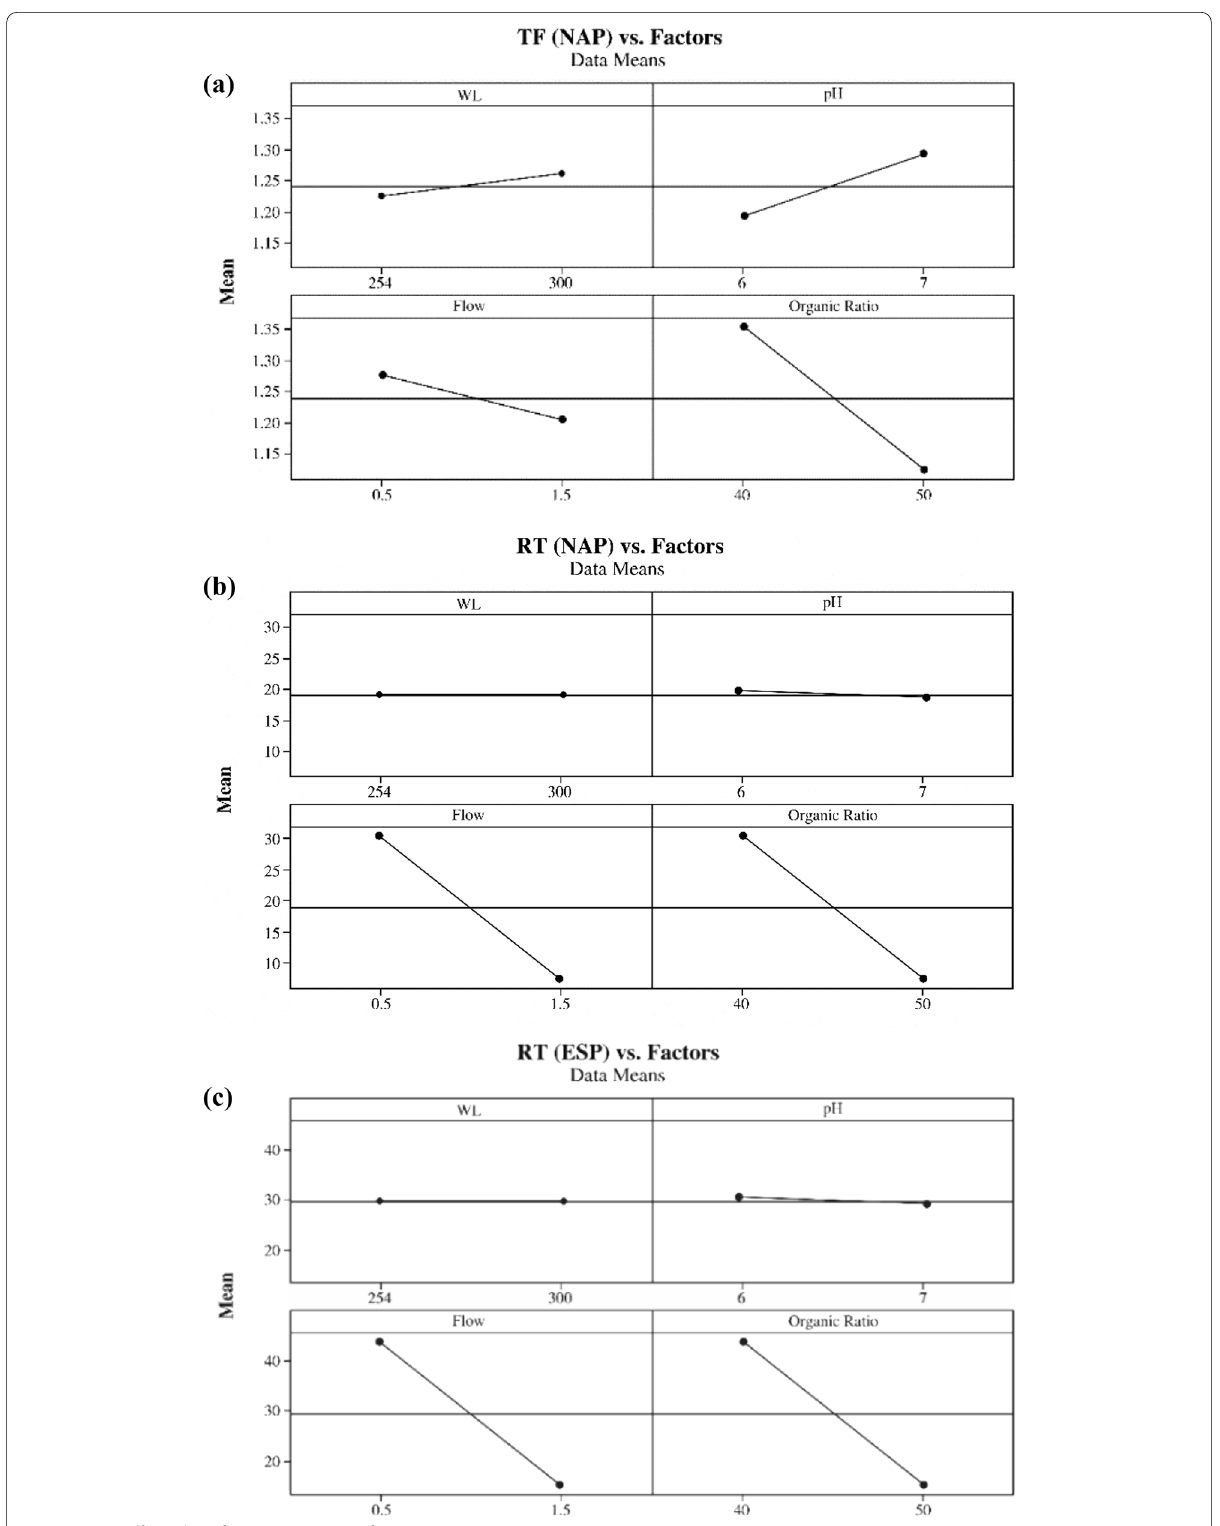
Fig. 8 Main effect plot of responses versus